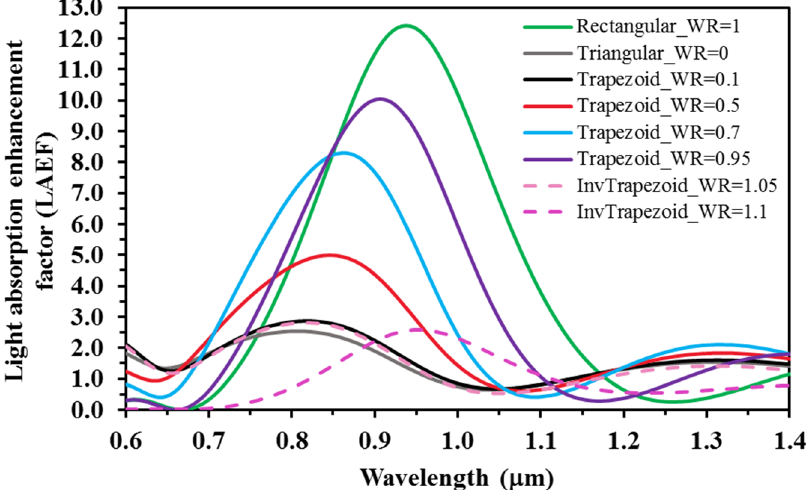
Figure 6. Light absorption enhancement factor (LAEF) spectrum of MSM-PD for various grating shapes. Note that 50% duty cycle, a constant of 100 nm grating thicknesses, and slit width of 50 nm were considered during the simulation process. The working ratios used for the nano-grating structures are presented in the figure legend [76].